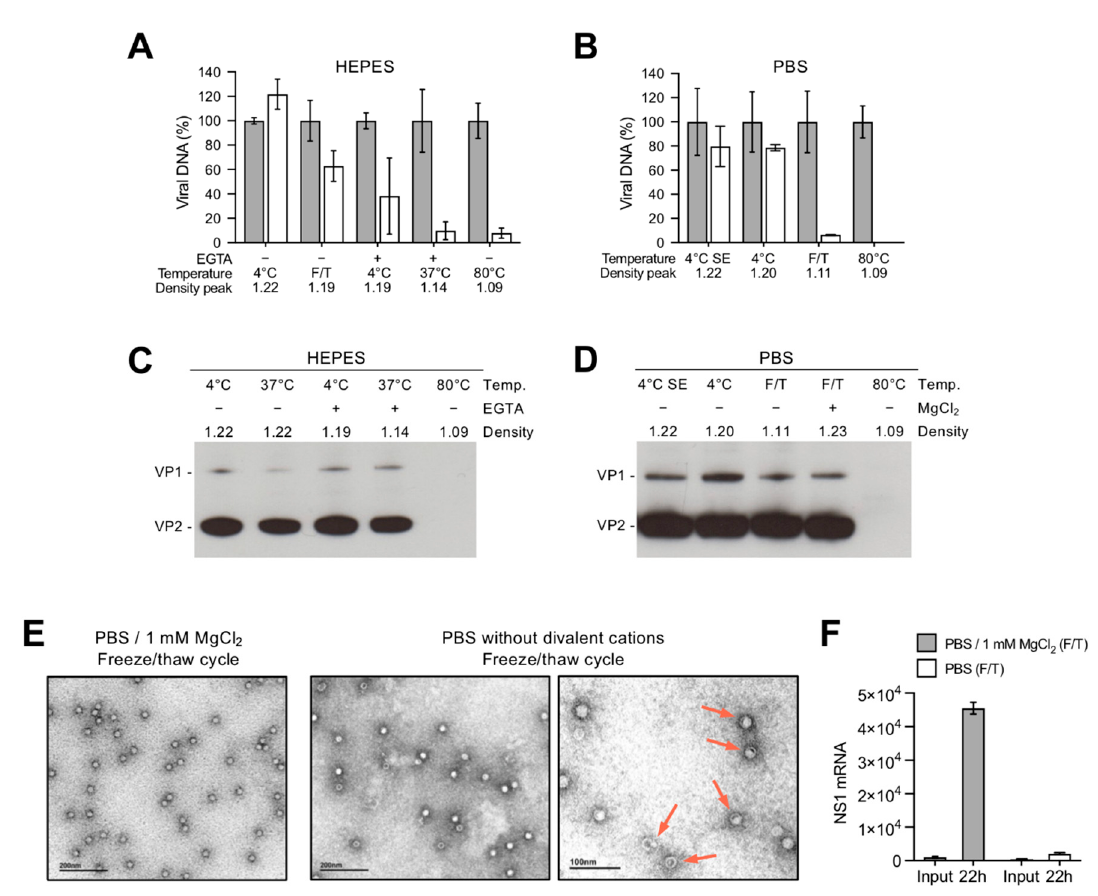
Figure 3. DNA accessibility and capsid integrity of the di ff erent B19V density populations. ( A , B ) Nuclease sensitivity of viruses in HEPES or in PBS displaying di ff erent densities. Virus samples from representative density populations were treated with DNase I at 37 ◦ C for 1 h (white columns). Virus treated at 80 ◦ C for 5 min was used as control. ( C , D ) Integrity of capsids in HEPES or in PBS displaying di ff erent densities. Virus samples from representative density populations were immunoprecipitated with the conformational antibody 860-55D against assembled capsids. Virus treated at 80 ◦ C for 5 min was used as control. ( E ) Transmission electron microscopy (TEM) images of B19V in PBS alone and PBS supplemented with 1 mM MgCl 2 and exposed to a freeze / thaw cycle. Arrows indicate capsids with rearranged DNA. ( F ) Infectivity assay based on NS1 mRNA detection with the same B19V preparations used for TEM. SE; short exposure. F / T; freeze and thaw. Values correspond to genome equivalents per microliter (geq / µL).